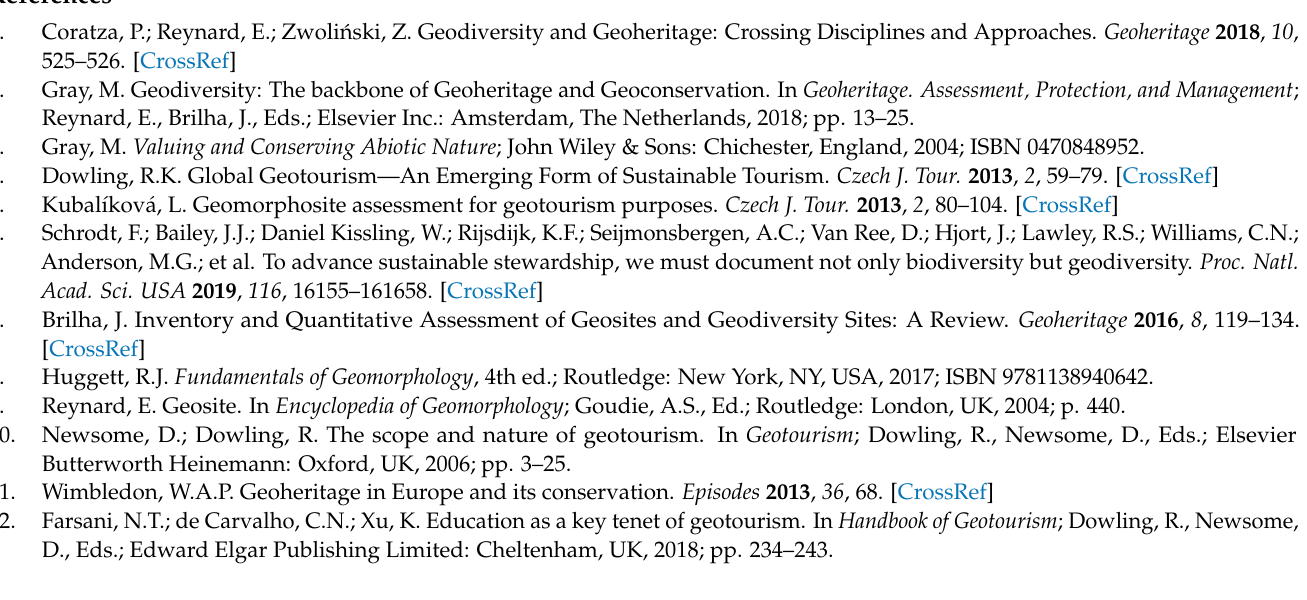
Figure A1. Number of persons in the NGB-NV group (total = 104) and their educational background.